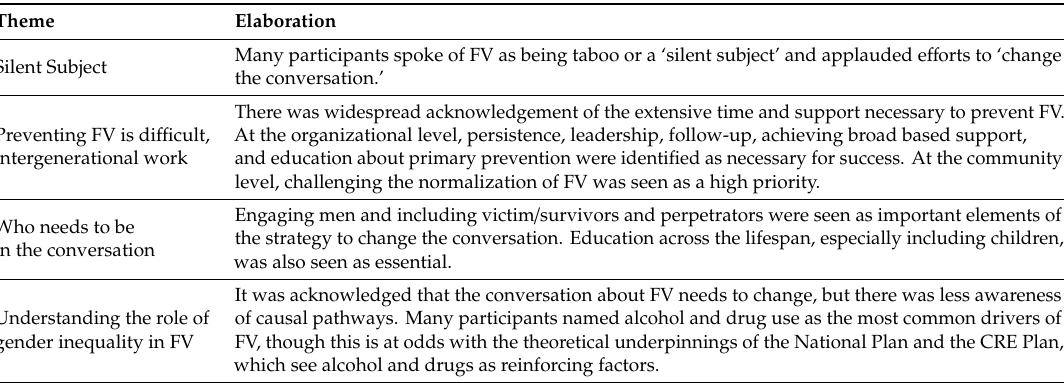
Table 1. Key themes